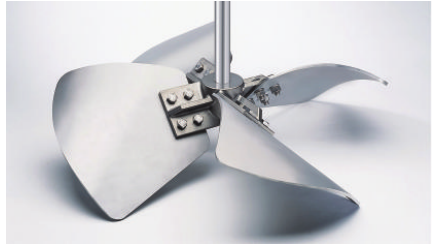
Figure 6: Chemineer Maxflo W impeller.